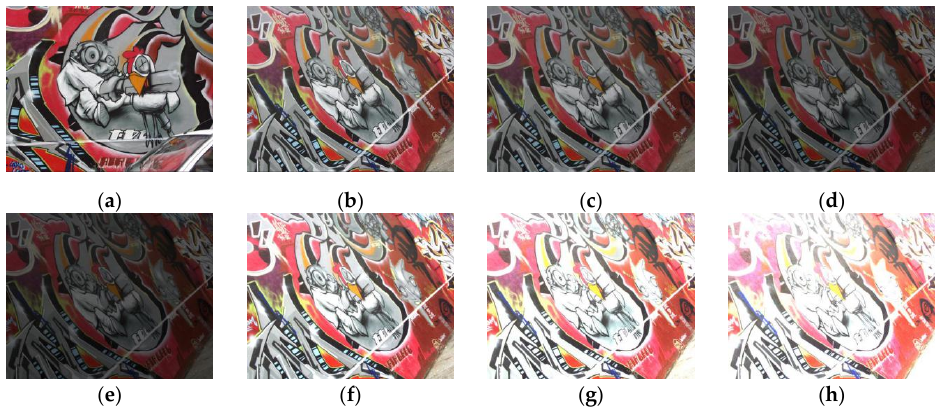
Figure 7. Graffiti sequence. ( a ) Normal Graffiti; ( b ) New Graffiti with a viewpoint changing angle of